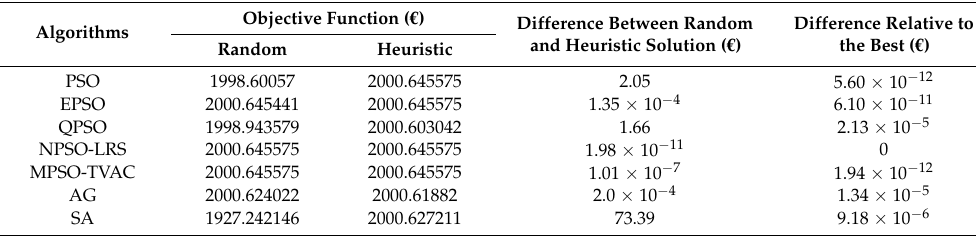
Table 3. Objective function difference